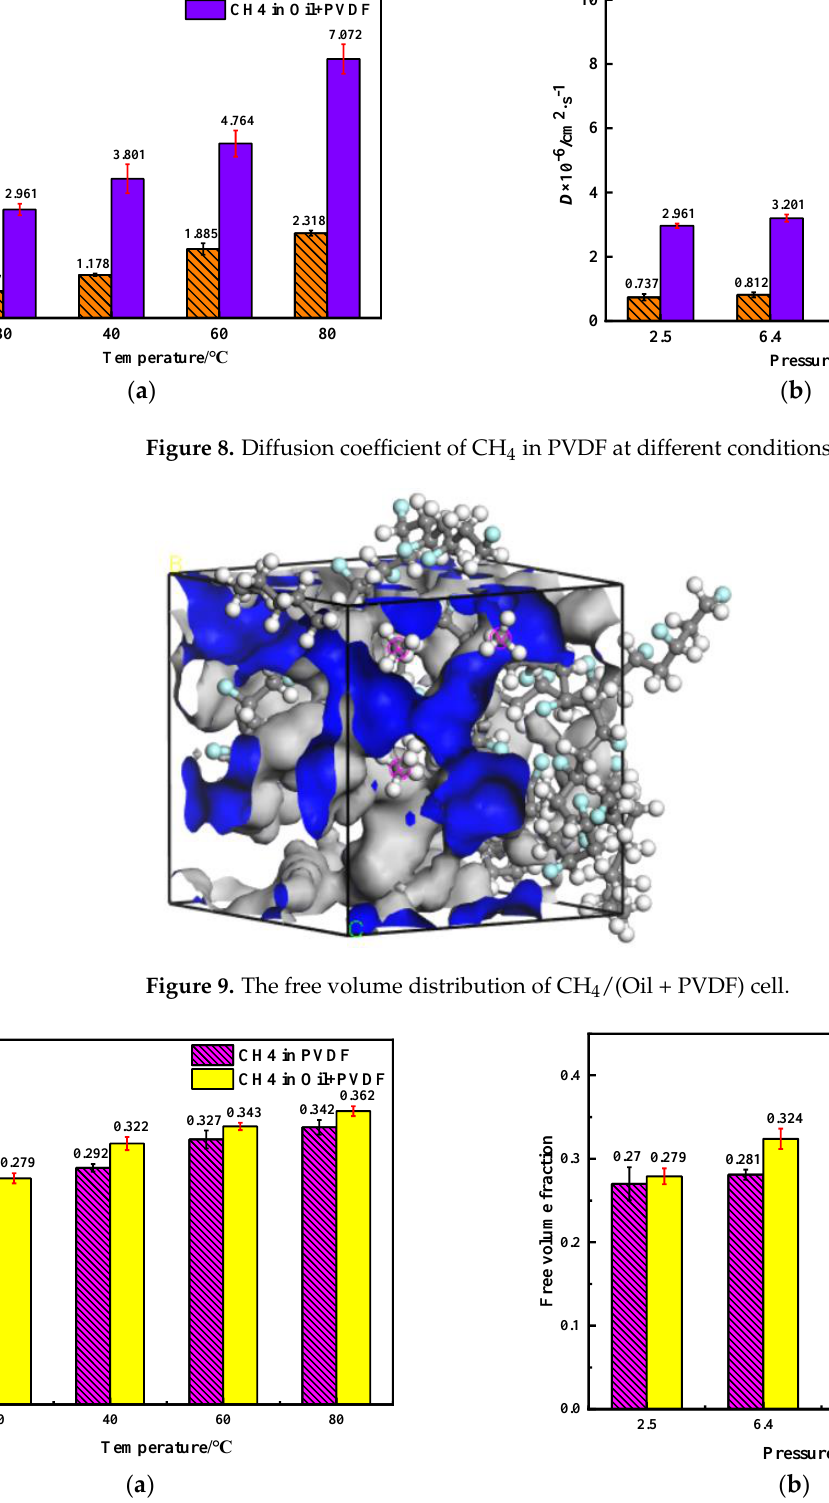
( b ) Figure 11. Permeability coefficient of CH 4 in PVDF under different conditions: ( a ) 2.5 MPa, ( b ) 30 °C. 4.2. Permeation Mechanism of CH 4 in PVDF Containing Crude Oil The density field distribution and isopycnic of CH 4 molecules in PVDF containing crude oil were obtained via the Sorption module to qualitatively study the adsorption sites, as shown in Figure 12. The adsorption density field distribution represents the concentrated area of the density distribution of gas molecules in the simulated cell. The scattered area in Figure 12a is the distribution location of adsorbed CH 4 molecules in PVDF containing crude oil. It can be seen that the adsorption sites are selective aggre- gated rather than uniformly distributed. The isopycnic display diagram is a display mode that combines energy and density information. As shown in Figure 12b, the color